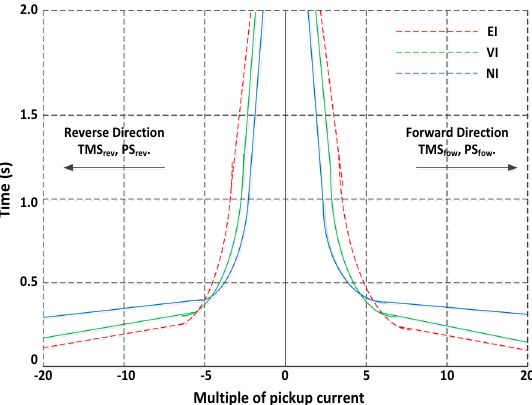
Fig. 1 Time–current characteristics of a dual setting DOCR